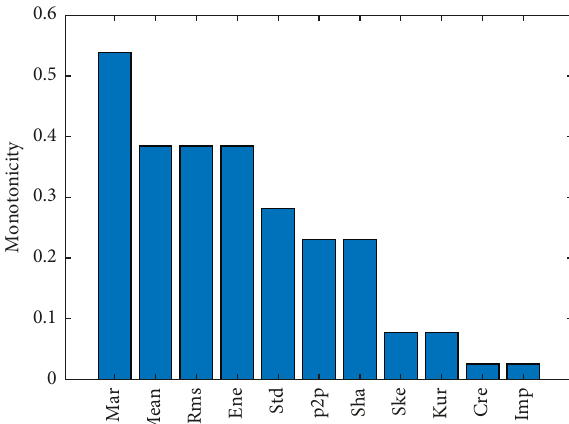
Figure 5: Monotonicity values of 11 time-domain features.